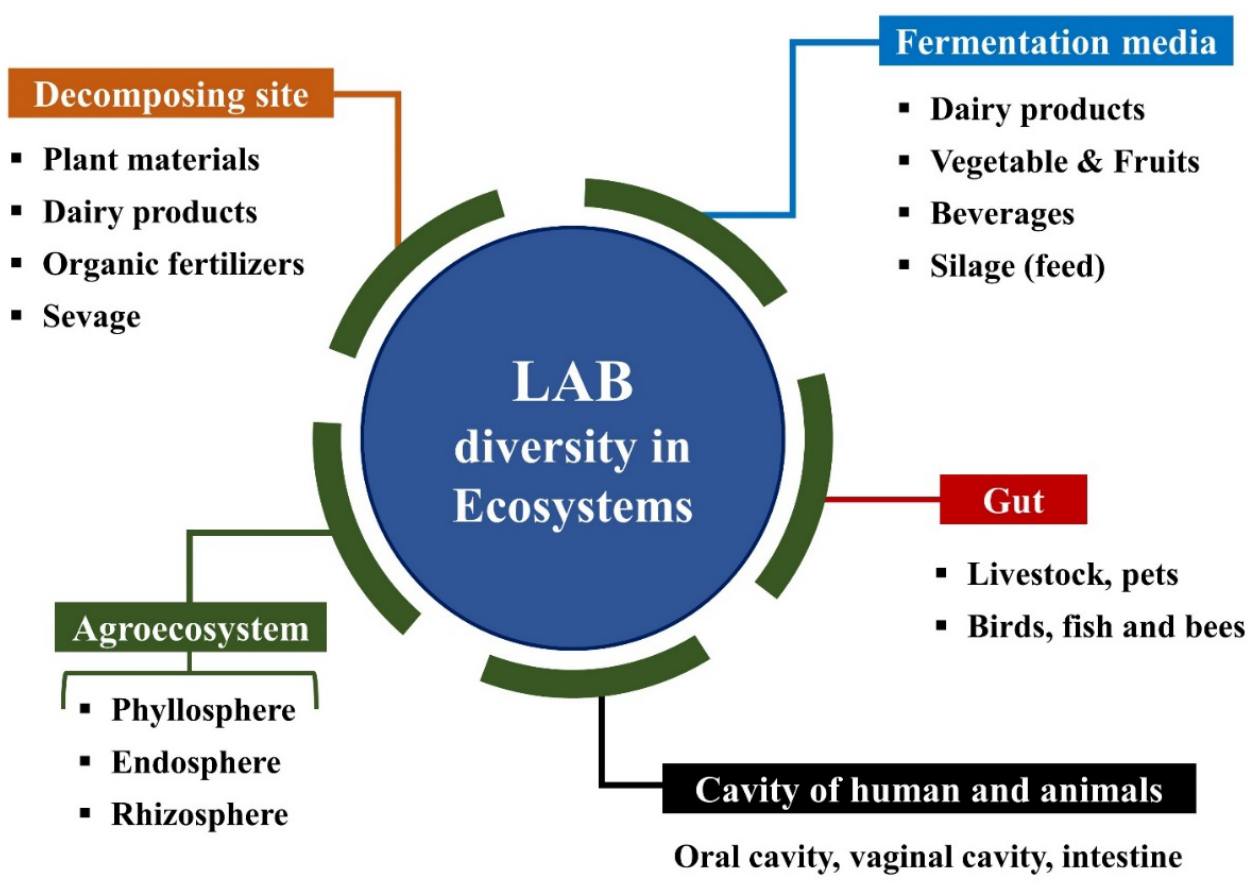
Figure 2. LAB occurrence and dynamism in distinct ecology niches: A widespread application in agricultural, environmental and functional health properties.